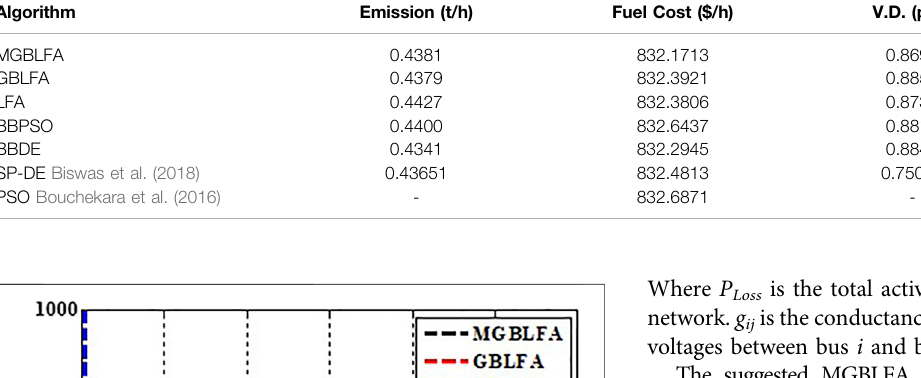
TABLE 6 | Comparison of optimal results by algorithms for Case 5. Algorithm